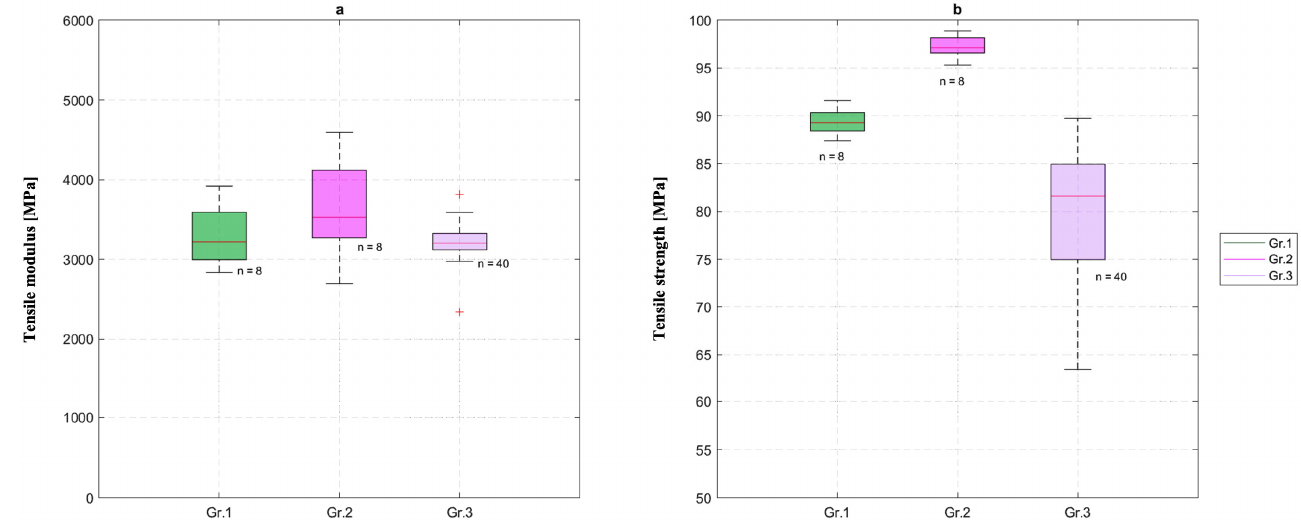
Figure 4. Distribution of ( a ) tensile modulus and ( b ) tensile strength of groups 1 to 3.